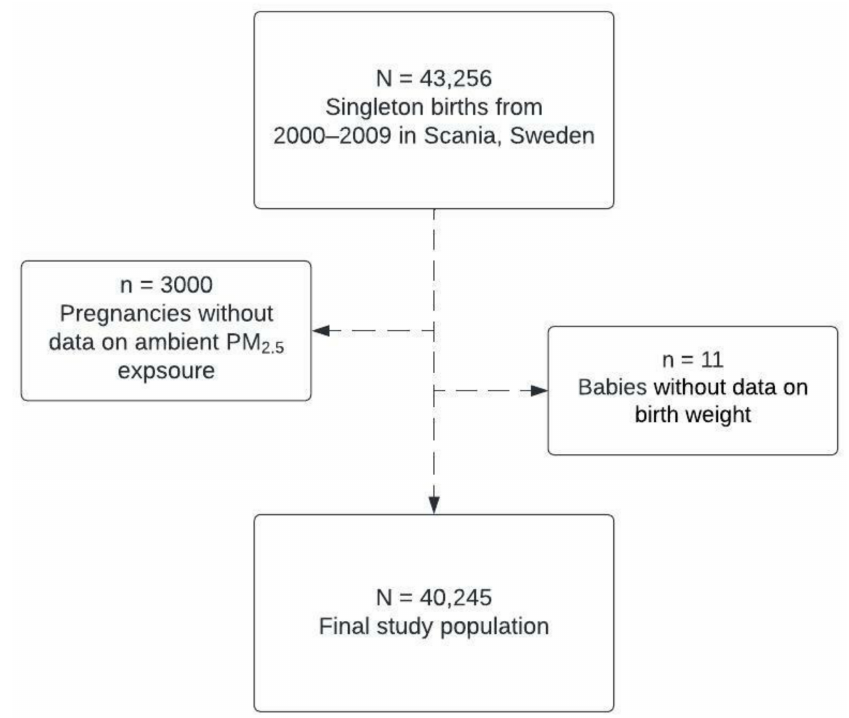
Figure 1. Flowchart of the study population by missing data on exposure (ambient PM 2.5 ) and outcome (birth